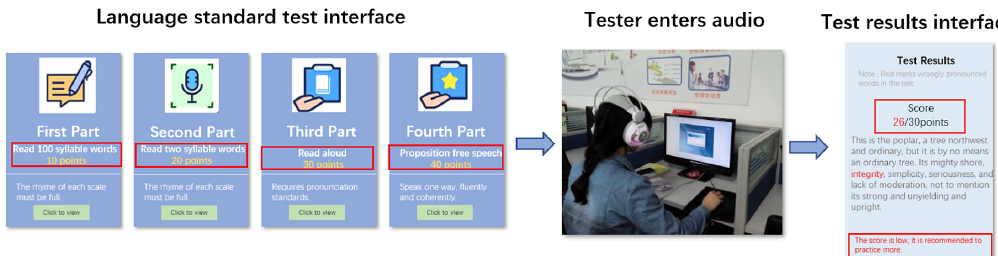
Figure 4. Test process of the traditional language evaluation system. The language standard test interface displays the four parts of the language test. The test contents marked by the red rectangle are made based on the gauge. The Test results interface displays the audio test results of “Read